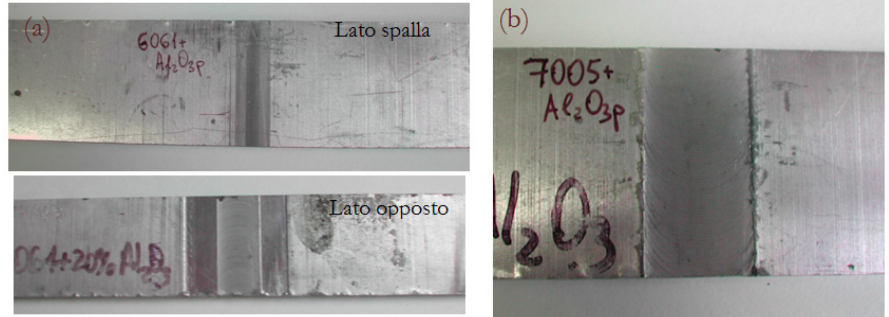
Figura 2: Morfologia dei giunti Friction Stir Welding su (a) W6A20A e (b) W7A10A.